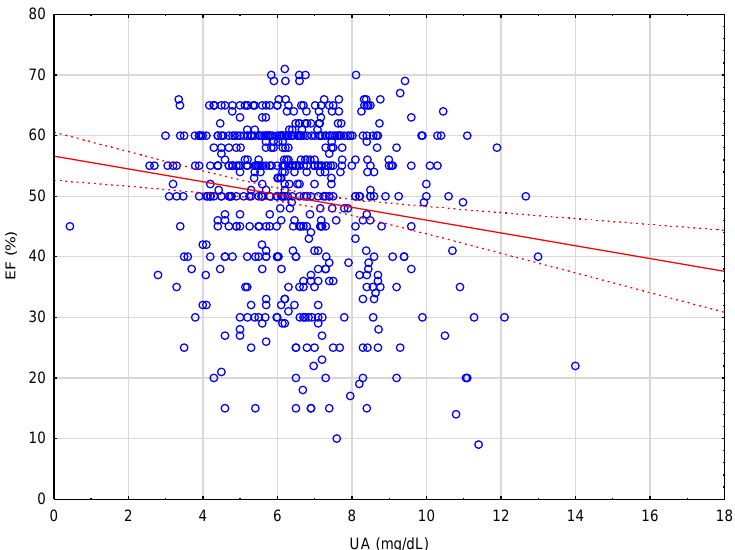
Figure 2. Scatterplot shows EF (%) as a function of UA (mg/dL). Cases with missing data were ex-